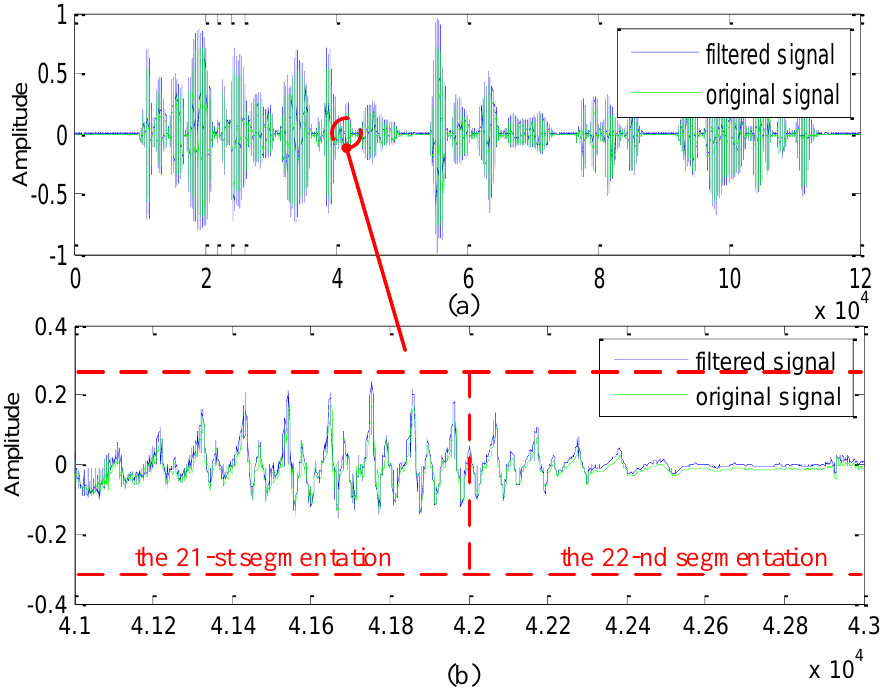
Figure 12. The original waveform and the recovered waveform. ( a ) The entire waveforms. ( b ) Edges linking to the 21-st subsegment and the 22-nd